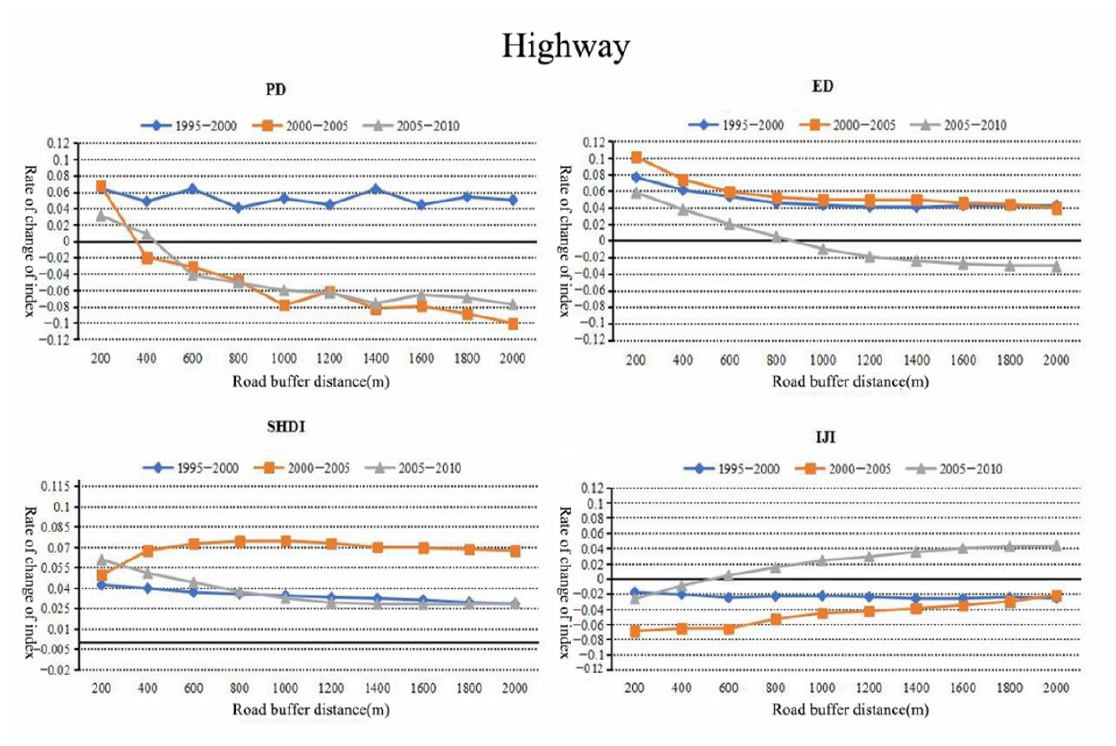
Figure 4. Graph of the correlation between index change rate and buffer distance (highways).